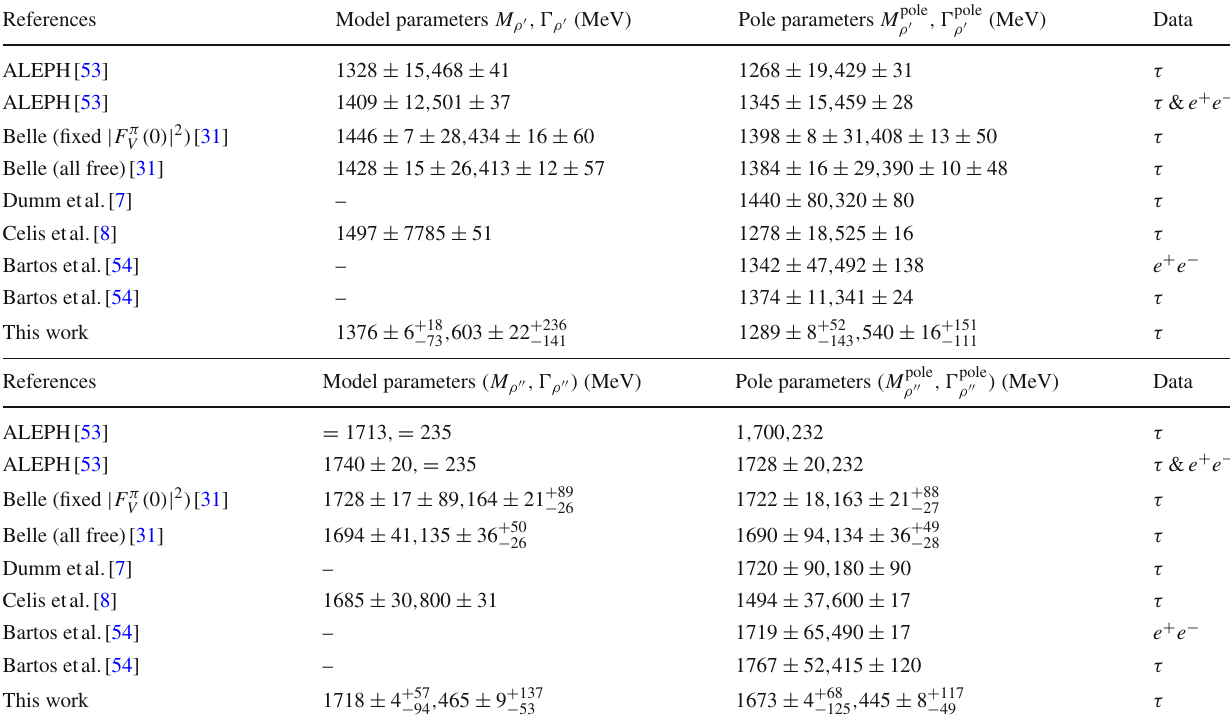
Table 4 Comparison between different results for the model parameters and corresponding pole positions for the ρ (cid:4) (upper table) and ρ (cid:4)(cid:4) (lower table) resonances. The first and second errors refer, respectively, to the statistical and systematic